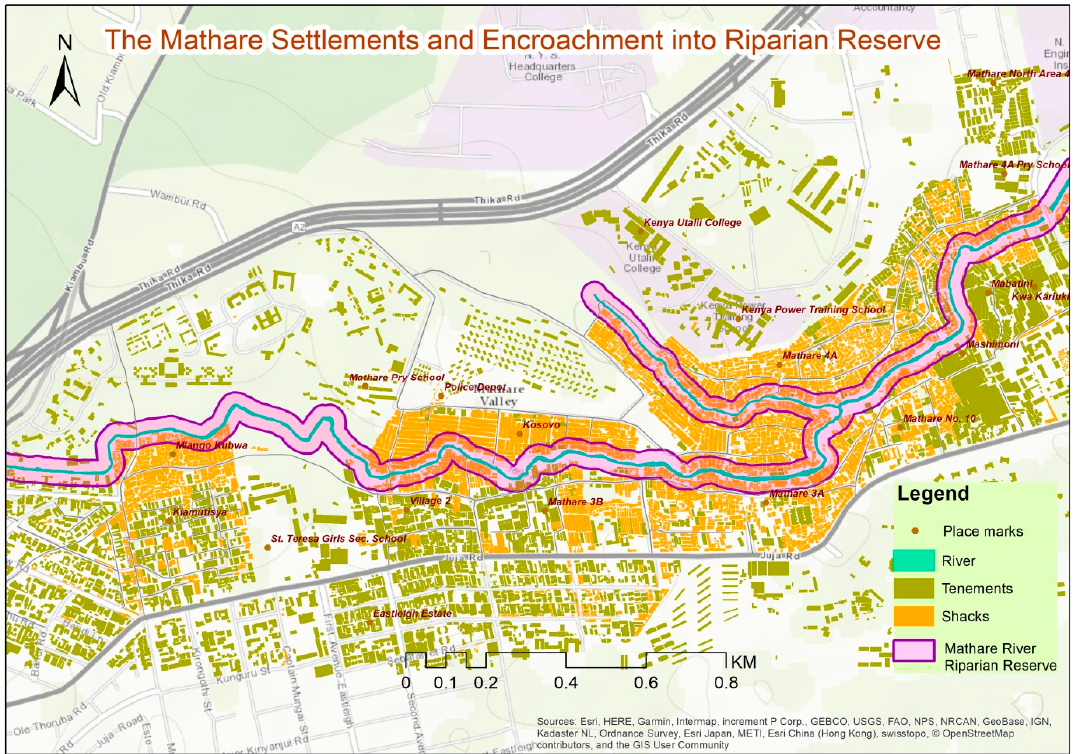
Figure 3. Map showing human encroachment along the Mathare River (Source: authors).